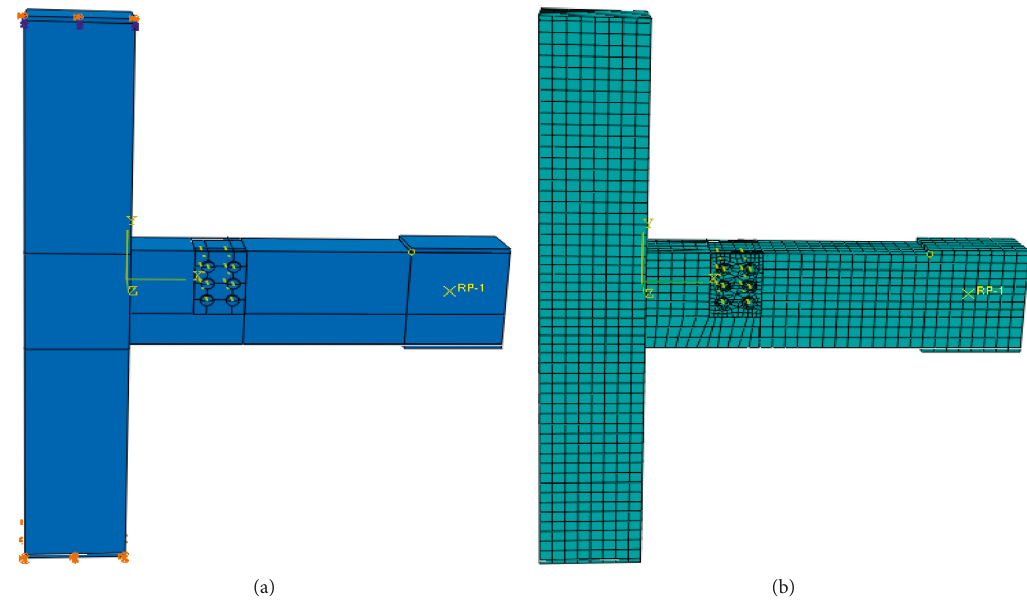
Figure 12: (a) Boundary conditions. (b) Meshes of FE models.